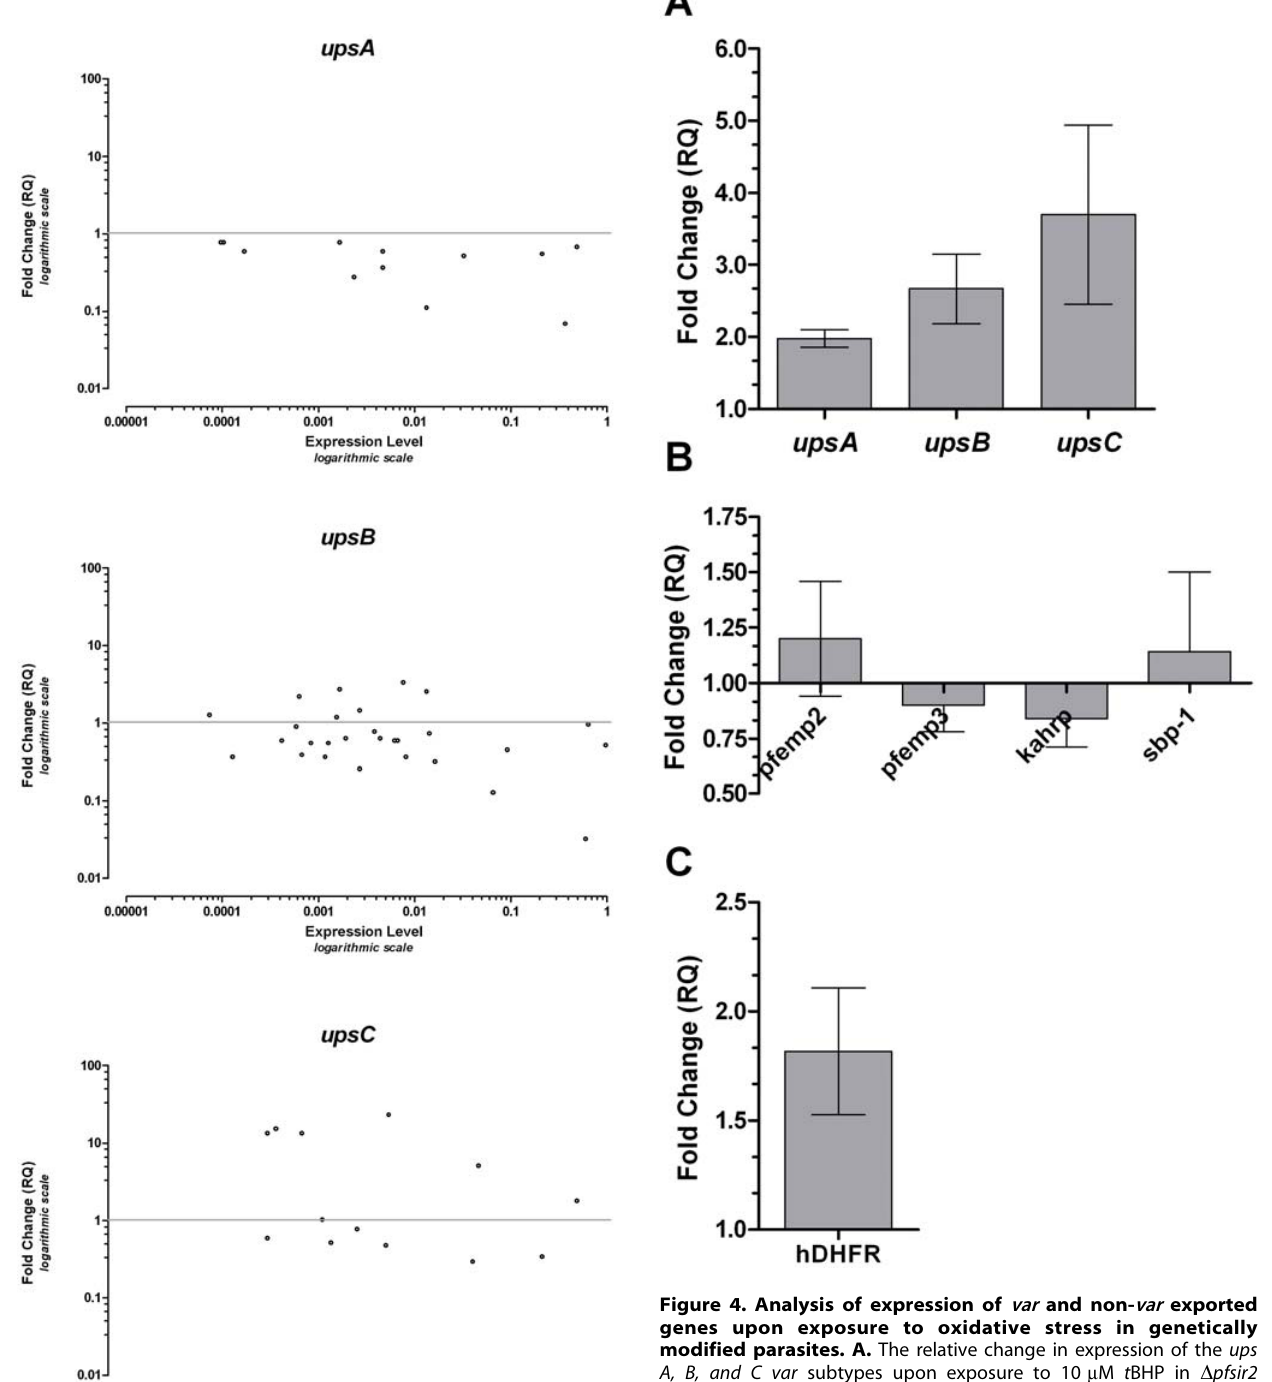
Figure 3. Fold change of individualvar genes upon exposure to oxidative stress plotted against expression levels. The data was plotted as logarithmic values of RQ versus the base-line logarithmic level of expression of each of the var genes. Marks above the horizontal line represent genes whose expression is induced and those below the line represent genes whose expression is reduced. Panels A, B and C show the breakdown to the respective ups subtypes.